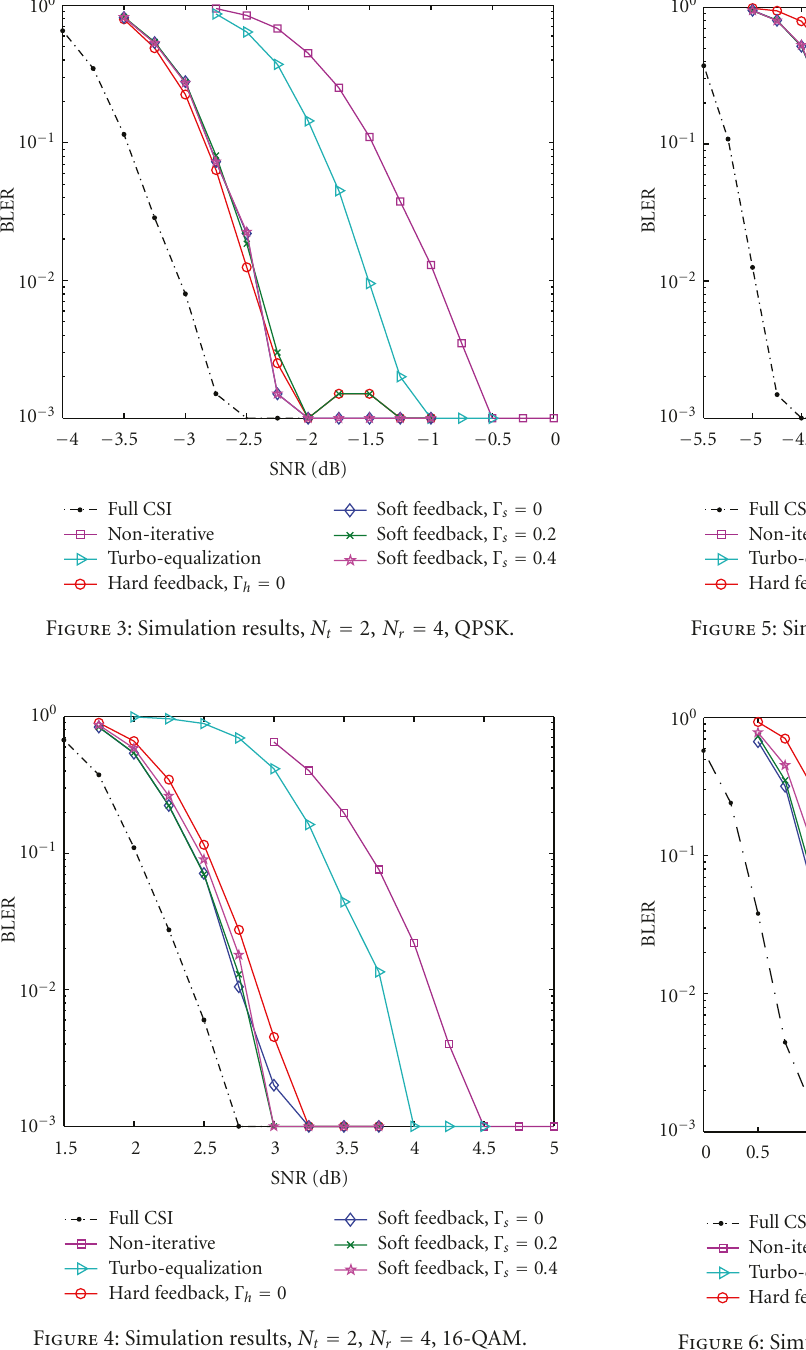
both the channel estimation and the MIMO detection in each iteration.